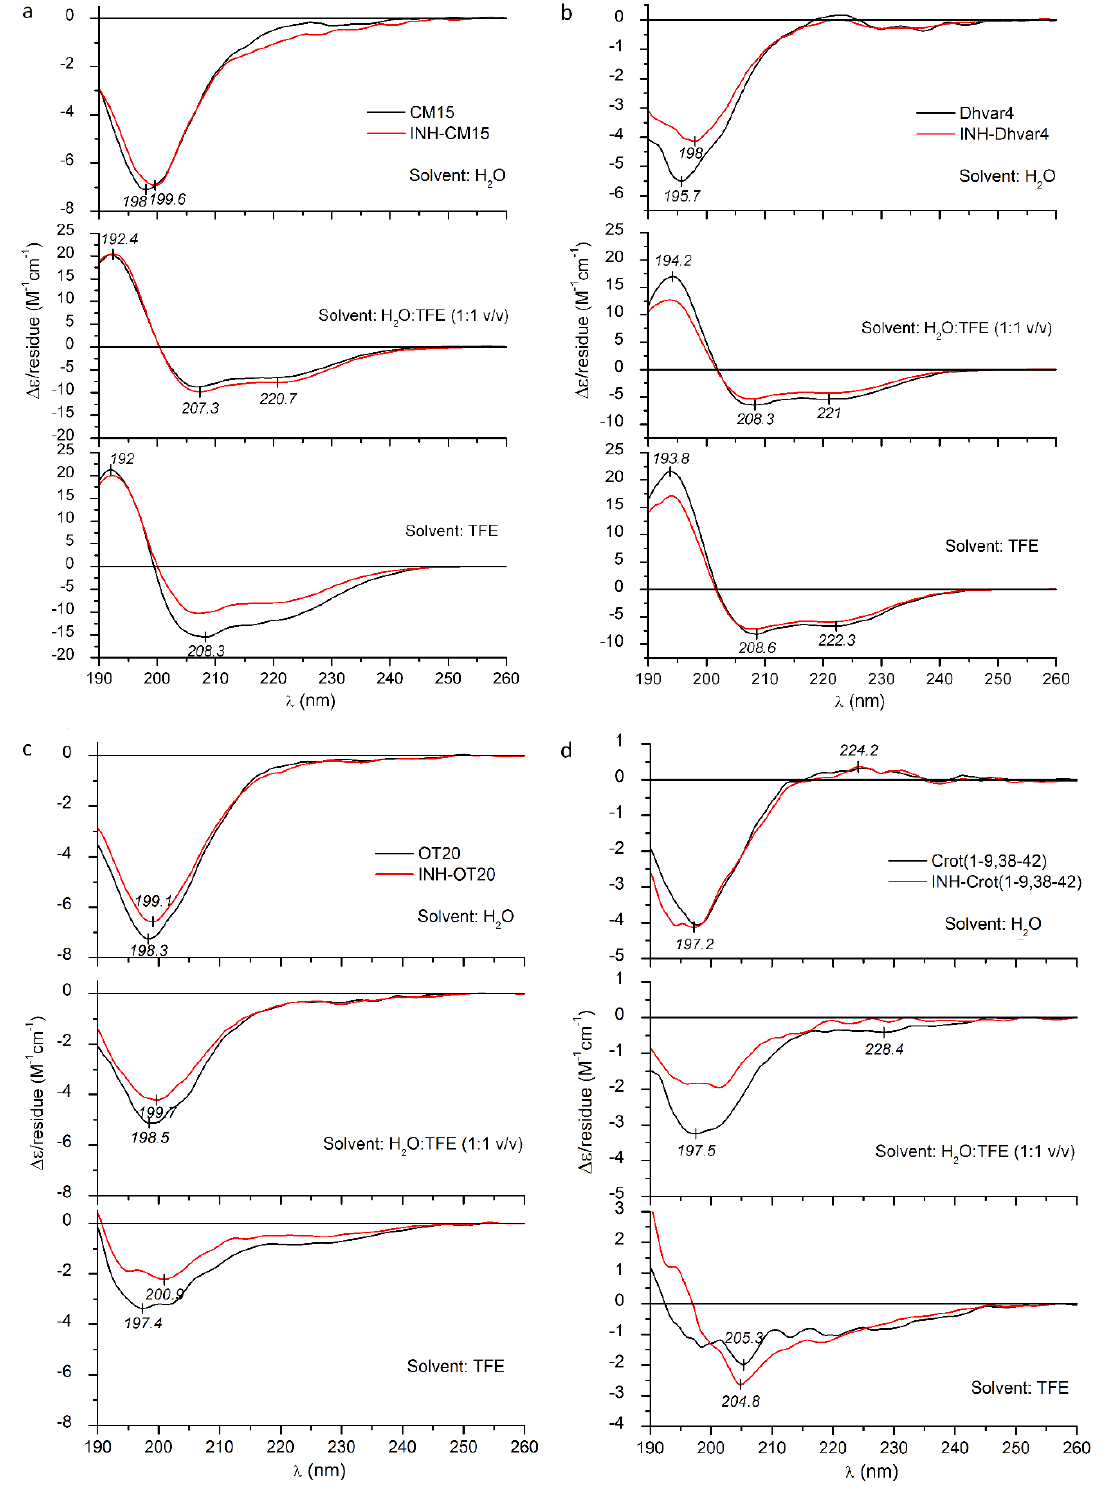
Figure 4. Far-UV CD spectra of CM15 ( a ), Dhvar4 ( b ), OT20 ( c ), Crot(1–9,38–42) ( d ) and their INH conjugates measured in deionized water, TFE and in water:TFE mixture.